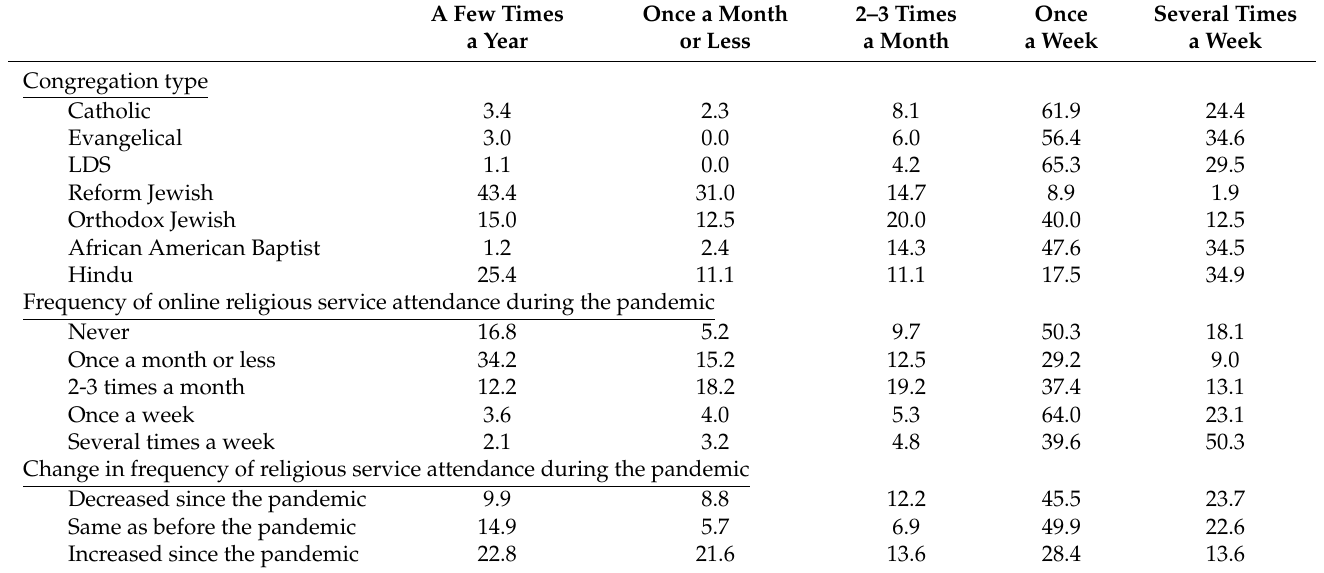
Table 2. Row percentages for the frequency of in-person religious service attendance before the pandemic by congregation type, by the frequency of online religious service attendance during the pandemic and by the change in frequency of religious service attendance from before to during the pandemic (n =